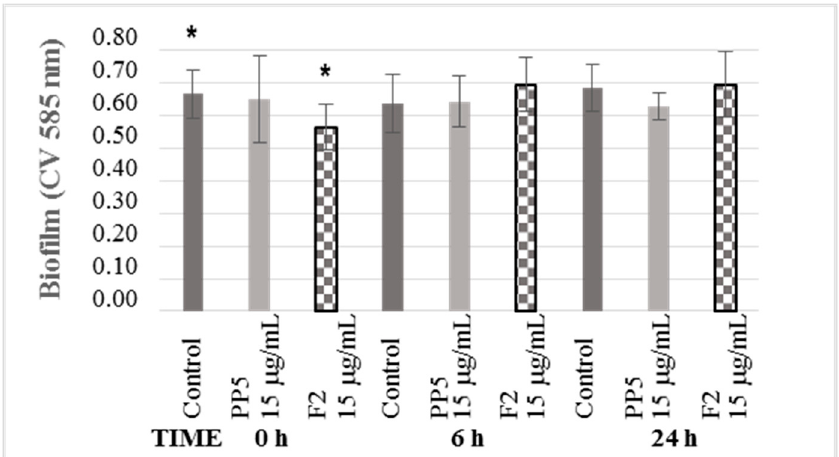
Figure 4. The kinetics of biofilm inhibition of the compounds. At 0, 6 and 24 h of incubation the compound was added, and the amount of biofilm formed was quantified by staining with violet crystal at 30 h. The asterisk (*) represents values lower than the average of the control of each compound concentration with statistically significant difference (* p < 0.05) (n = 5).